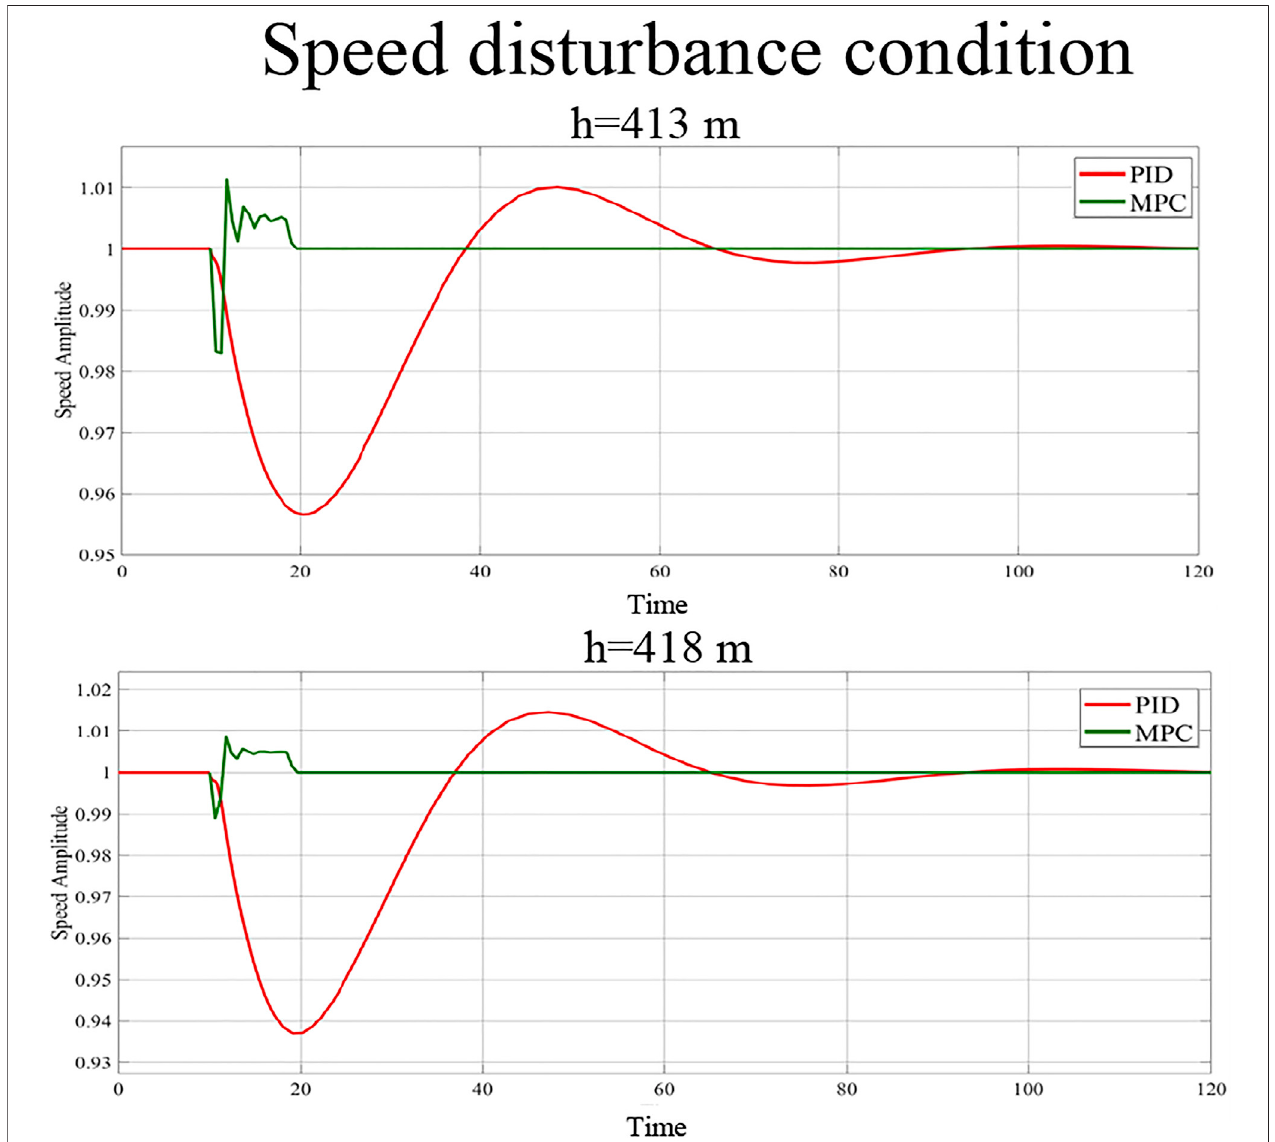
FIGURE 13 | Speed variation due to a speed disturbance under 413 and 418 m of water head.